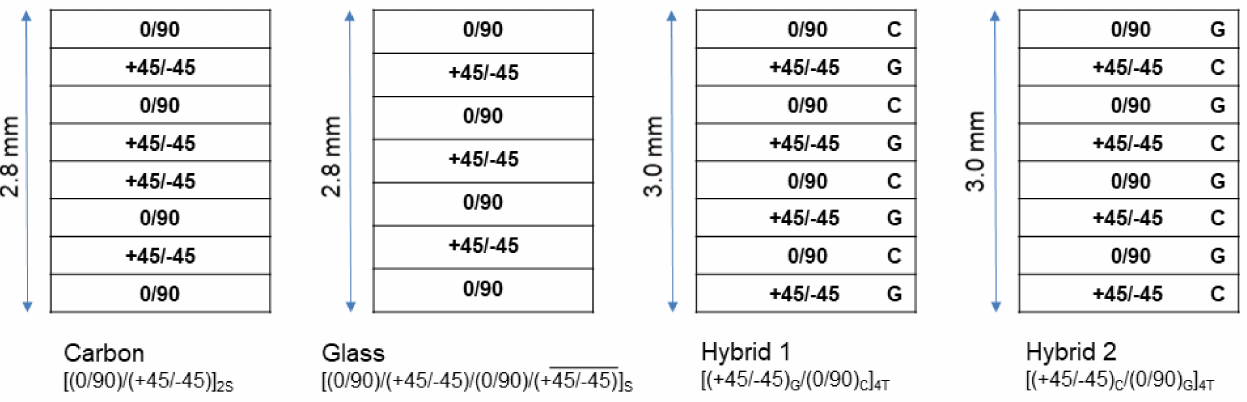
Figure 2. Lay-up sequence of carbon, glass and hybrid plates.